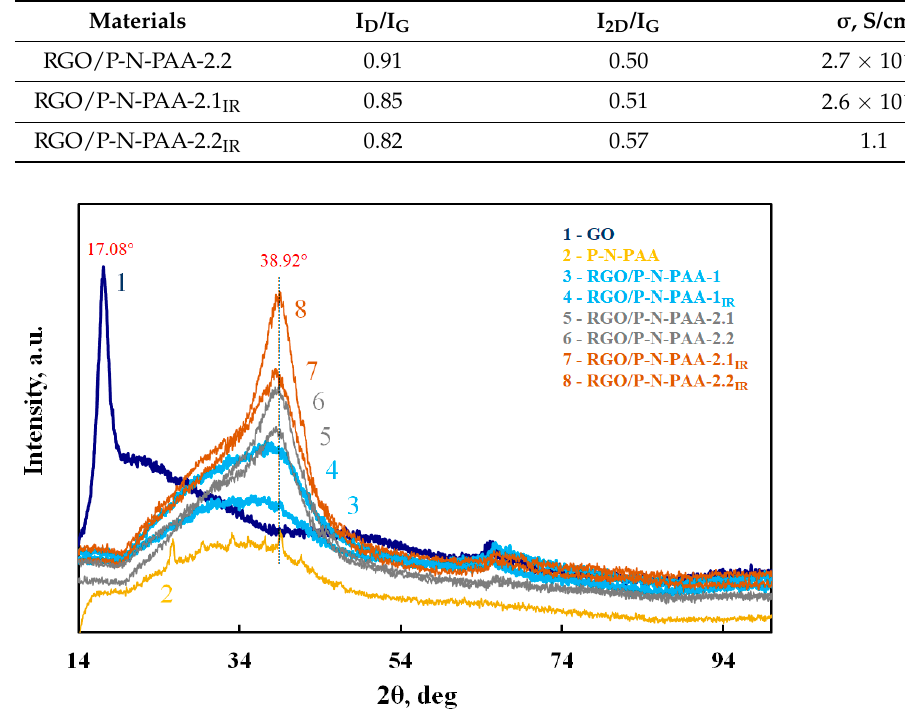
Figure 4. XRD patterns of GO (1), P-N-PAA (2), and RGO/P-N-PAA Figure 4. XRD pa tt erns of GO (1), P-N-PAA (2), and RGO/P-N-PAA (3–8). Table 2. The conductivity values of materials.